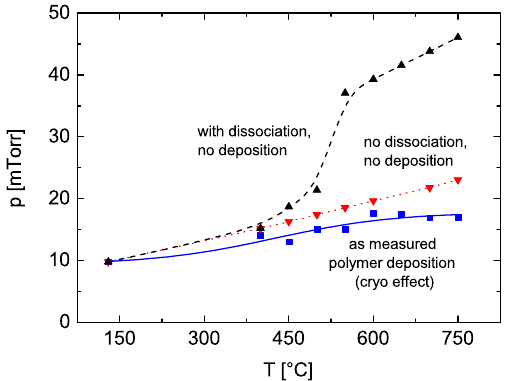
Figure 18. Comparison of the actual pressure (squares, solid, blue) with two scenarios: Linear pressure rise due to the ideal gas law (triangles down, dotted, red), and increased pressure rise beyond 375 ◦ C (onset of dissociation, triangles up, dashed, black)